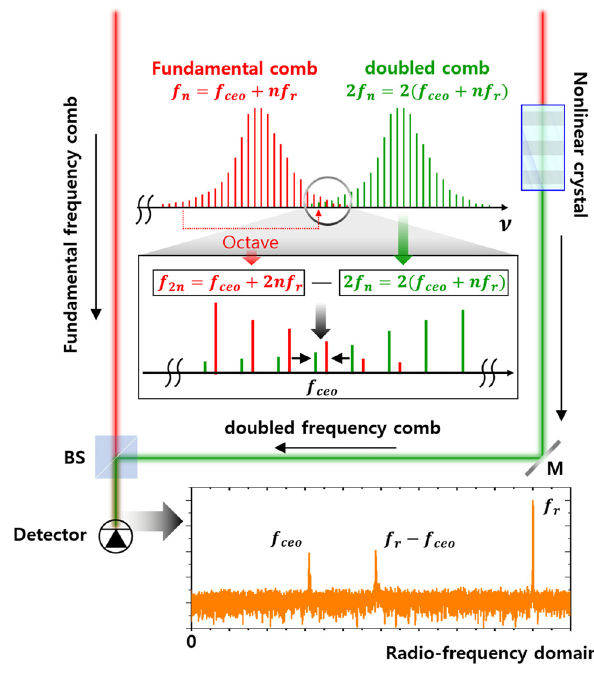
Figure 5: Working principle of the f – 2f interferometric optical synthesizer. The n th mode of the optical frequency comb at the red line, whose frequency is expressed as f ceo + nf r , is upconverted by a nonlinear crystal shown as the green line. The frequency of the upconverted comb is twice the frequency of the fundamental comb expressed as 2 ( f ceo + nf r ) . The 2 n th mode of the fundamental frequency comb ( f ceo + 2 nf r ) interferes with the frequency-doubled comb mode 2 ( f ceo + nf r ) when the optical frequency comb is assumed to covers a full optical octave. This yields the beat fre- quency, which is the carrier-envelope offset frequency f ceo in the RF